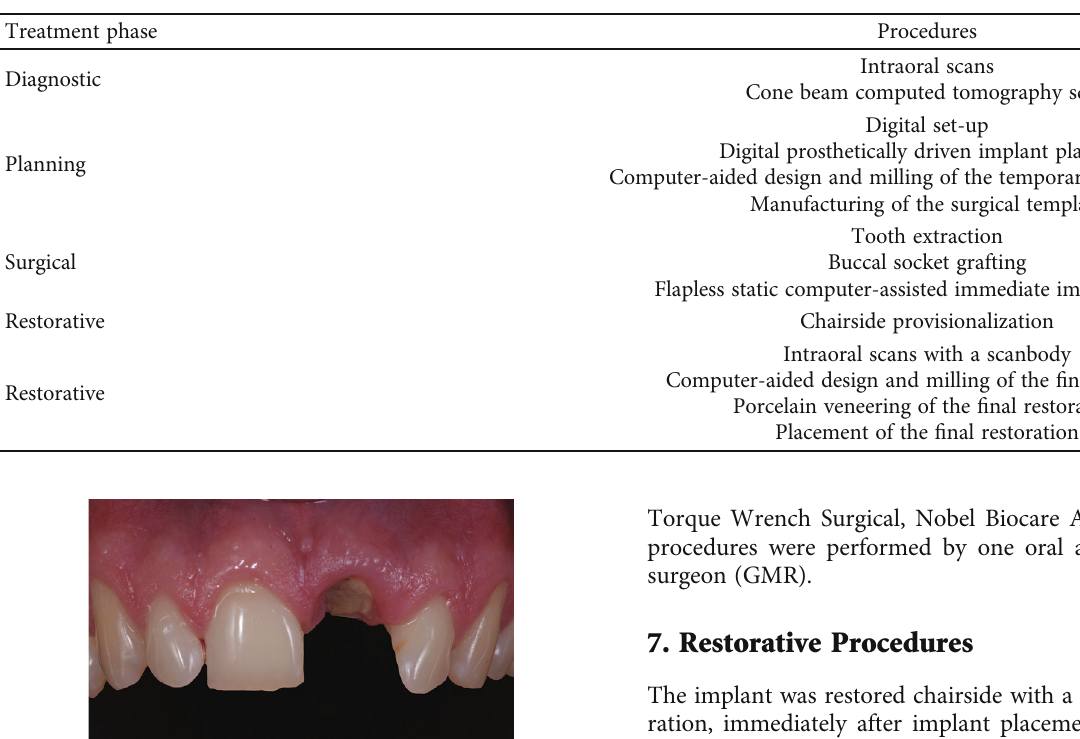
Table 2: Timeline of the immediate implant placement, provisionalization, and fi nal restoration treatment.